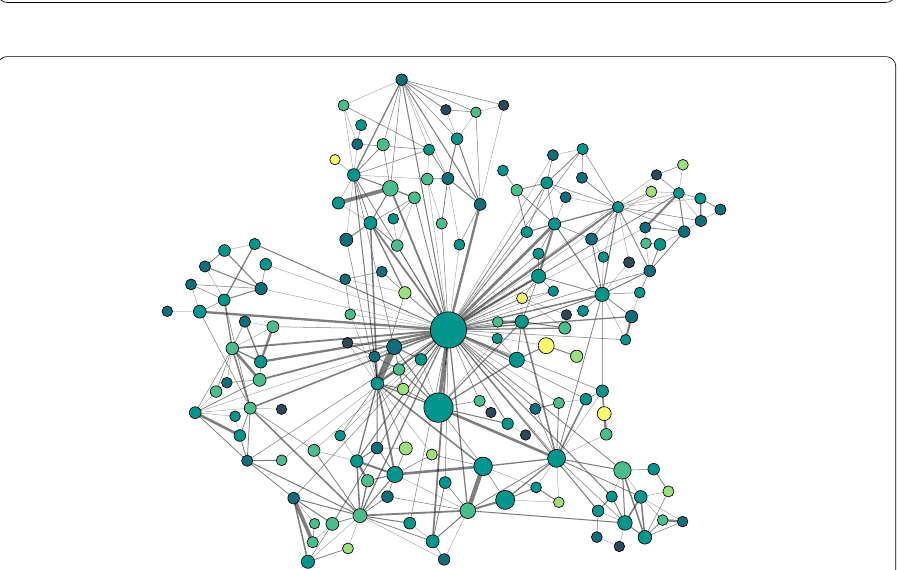
Figure 15 Company network. Each node represents a company. Links connect companies that share an insider. The thickness of a link is stronger when the companies share more insiders. For illustration purposes, the full network is reduced to Planar Maximally Filtered Graph. Number of nodes: 150, number of links: 386. The diameter of this network is 6 and the average degree is 5.15. The nodes are scaled per number of insiders in the company. The nodes are colored according to the proportion of male insiders. Percentage of male insiders in the company: - 100, -